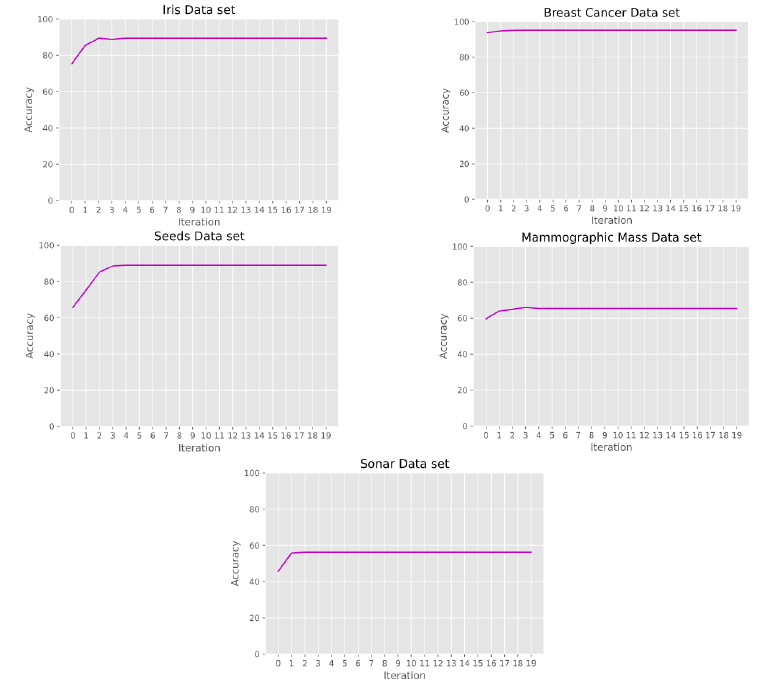
Figure 10. Accuracy using K-Means on the experimental data sets.